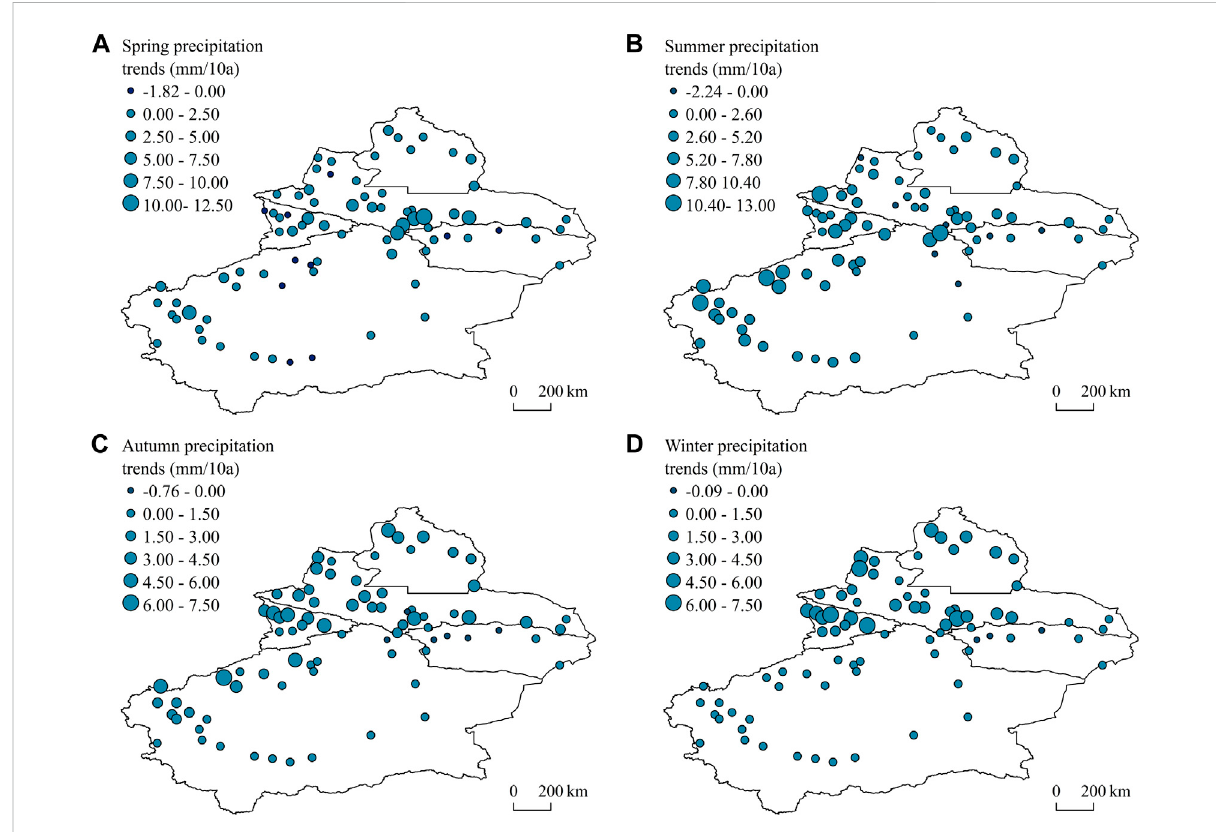
FIGURE 5 Variation trends in precipitation during different seasons (A – D) in XJ and its